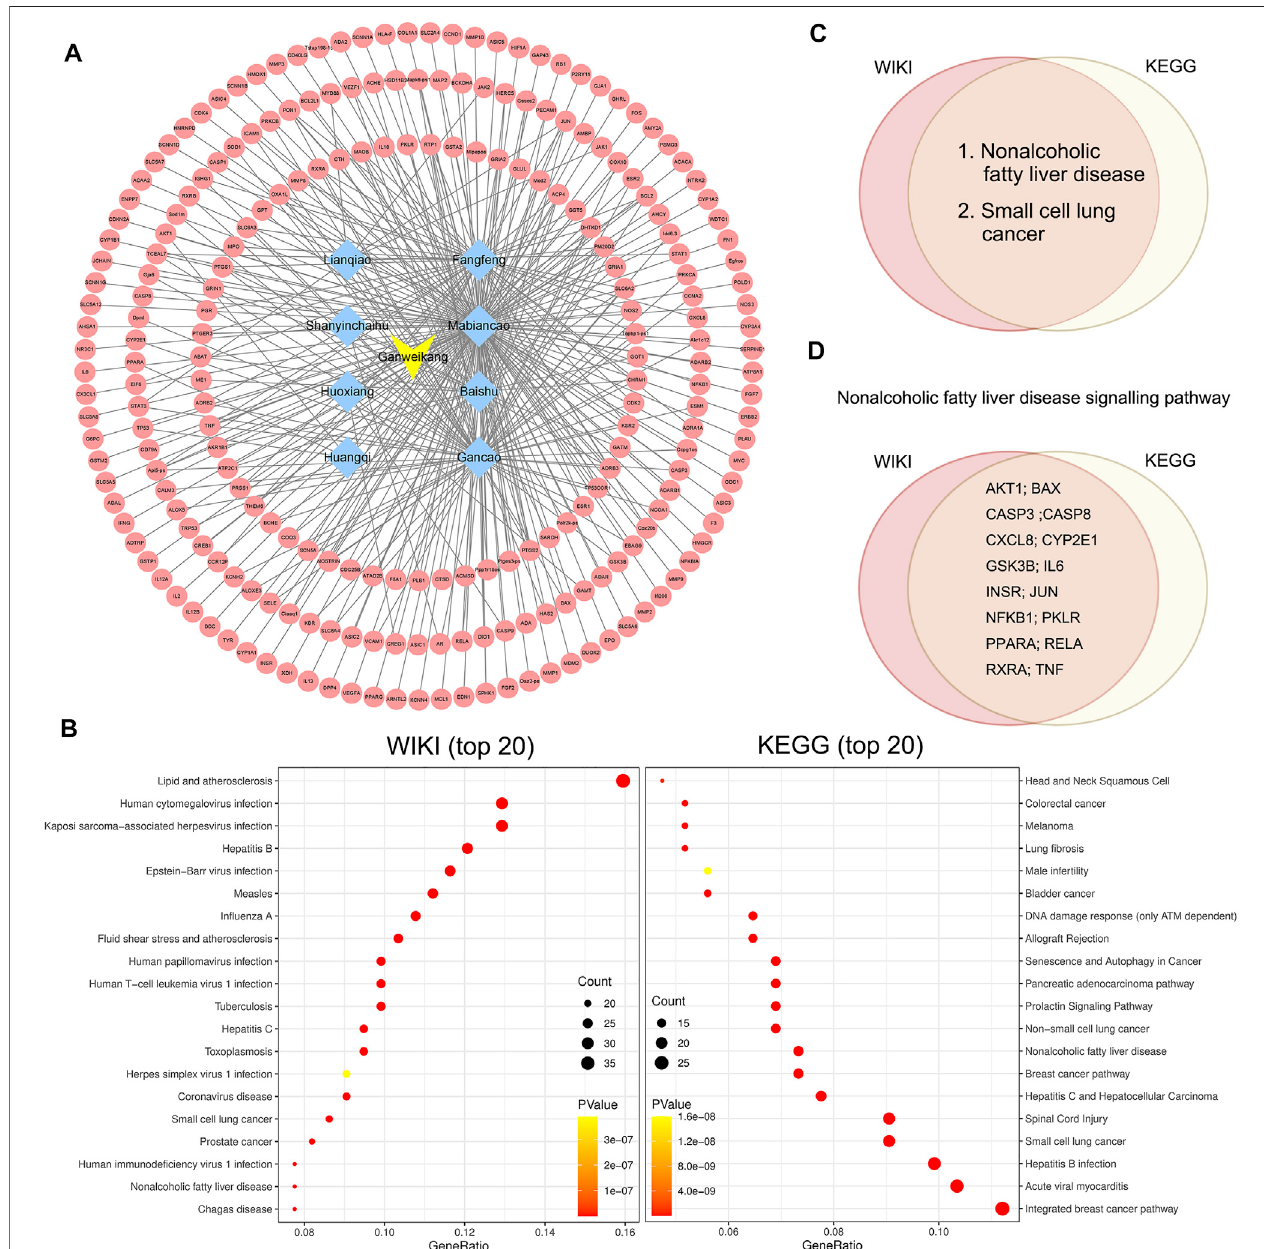
FIGURE 6 | Network pharmacology analysis on target genes and disease of the Ganweikang tablet. (A) Ganweikang tablet (yellow) – Chinese herbal medicine (blue) – target genes (red) network. (B) Enrichment analysis of Ganweikang tablet target genes in WIKI and KEGG diseases (top 20). (C) Venn diagram representing the intersection of Ganweikang tablet target genes in KEGG and WIKI-enriched diseases. (D) Venn diagram representing Ganweikang target genes that are co-owned by KEGG and WIKI in NAFLD.